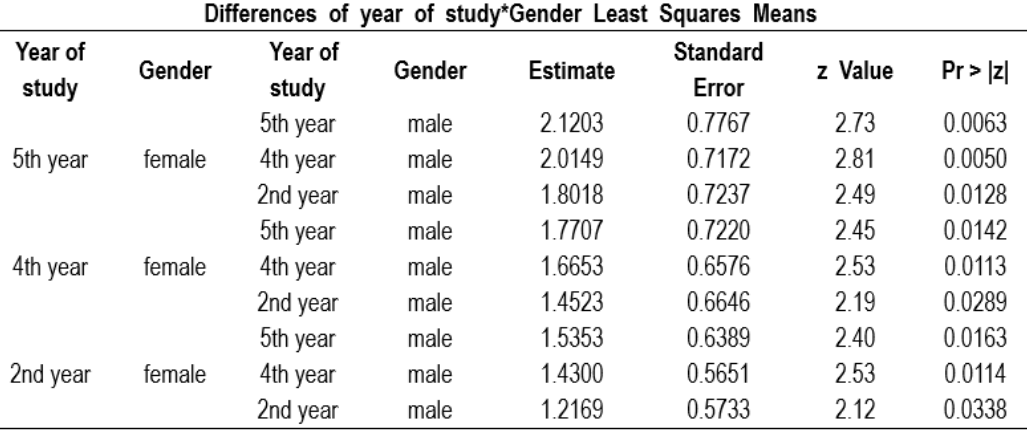
Tests of differences between LS-Means of logits for selected pairs of students’ categories determined by gender and year of